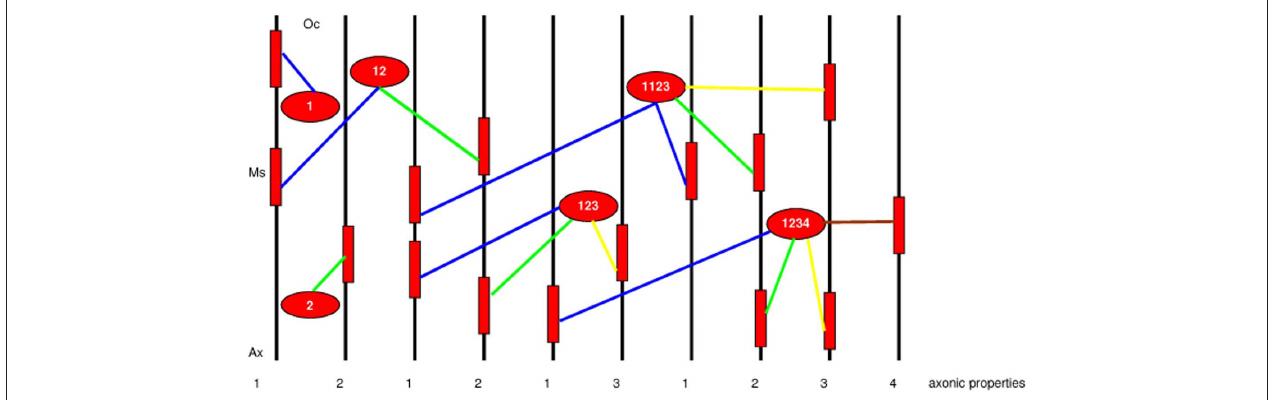
Figure 5 | example of an oligodendrocyte-axonic structure according to the rule of categorization (Table 1). Oligodendrocytes (Oc) and myelin sheaths (Ms) are represented in red color. Ten axons (black) with different or equal properties of information processing (1 … 4) are shown. Each oligodendrocyte is